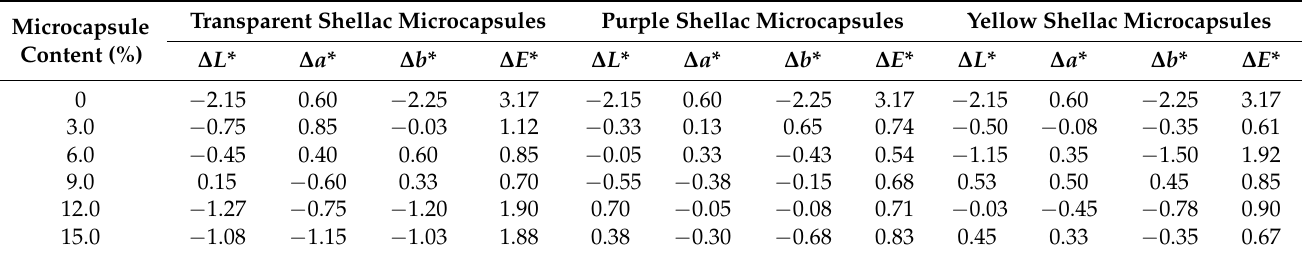
Table 3. Effects of different shellac materials on coating color parameters before and after